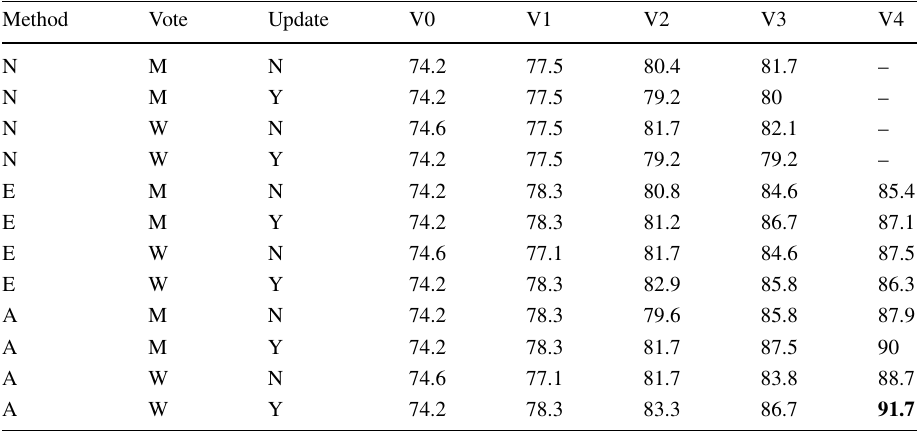
Table 3 Diabetic retinopathy sensitivity results